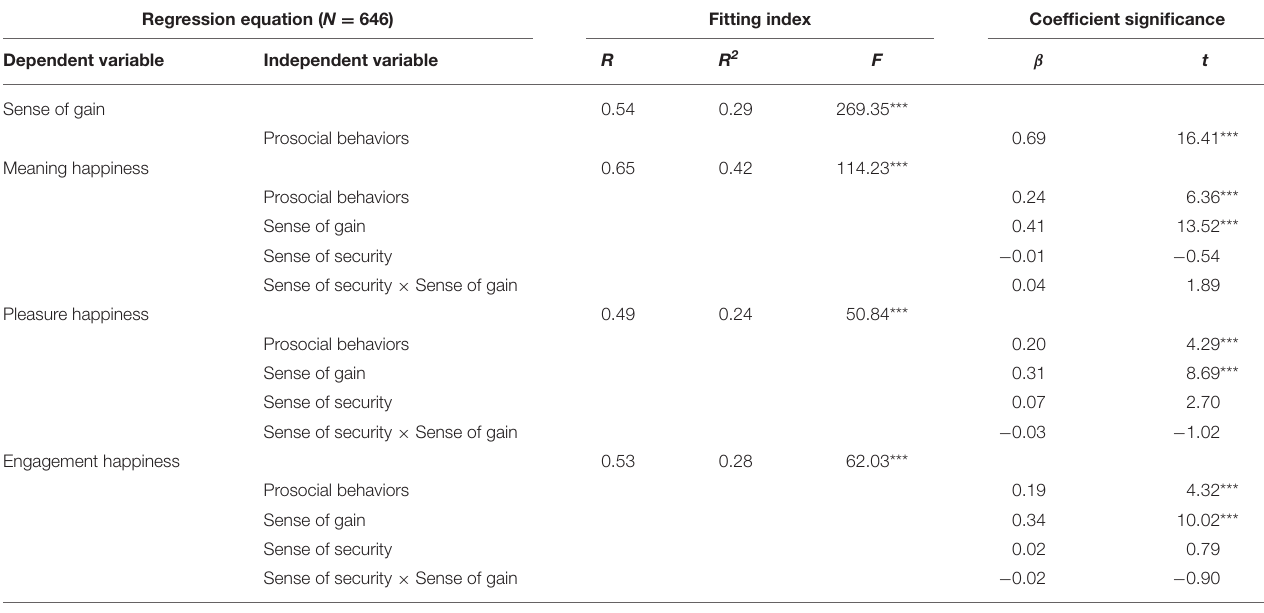
TABLE 3 | Regression analysis of moderated mediation effect.